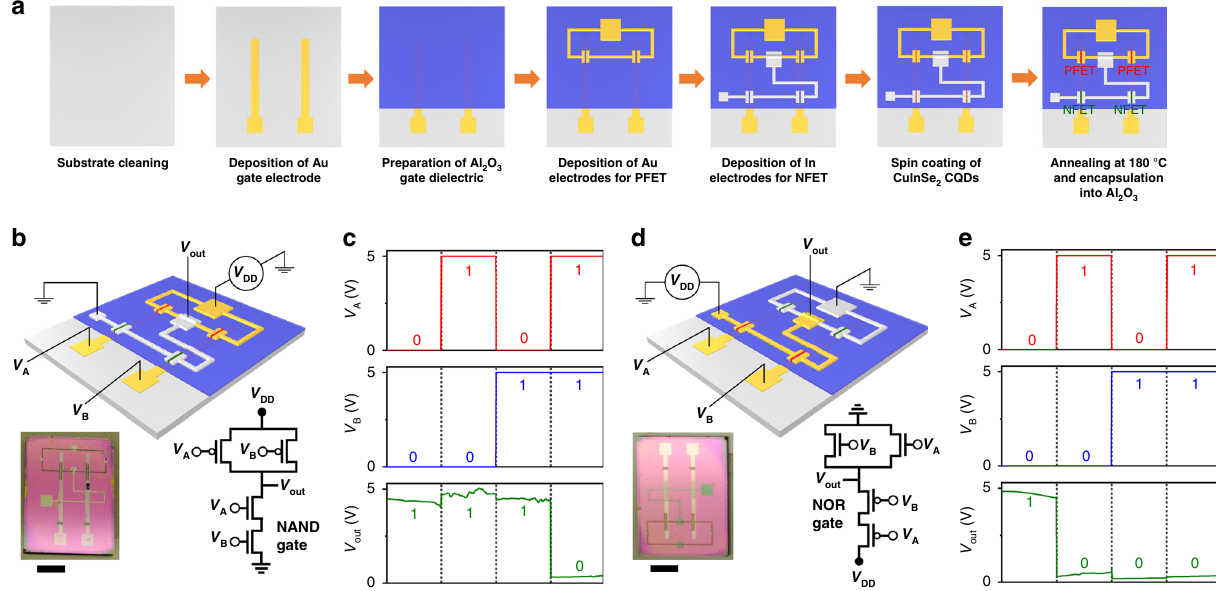
Fig. 5 CuInSe 2 -CQD-based integrated CMOS NAND and NOR logic gates. a Processing steps used to fabricate a CMOS NAND gate based on CuInSe 2 CQD PFETs and NFETs. Two separate Au gate electrodes are prepared for applying input voltages ( V A and V B ). b A schematic depiction (not to scale) of the fabricated CMOS NAND gate device (top) along with its photograph (bottom left) and the circuit diagram (bottom right); V DD = 5 V is the supply voltage and V out is the output voltage. c The measured output voltage of the NAND gate for four different combinations of input signals: ( V A , V B ) = (0, 0), (1, 0), (0, 1), and (1, 1). d , e Same as in ( b ) and ( c ), respectively, but for the fabricated NOR logic-gate device. Scale bars in panels ( b ) and ( d ) correspond to 5 mm. Source data are provided as a Source Data fi